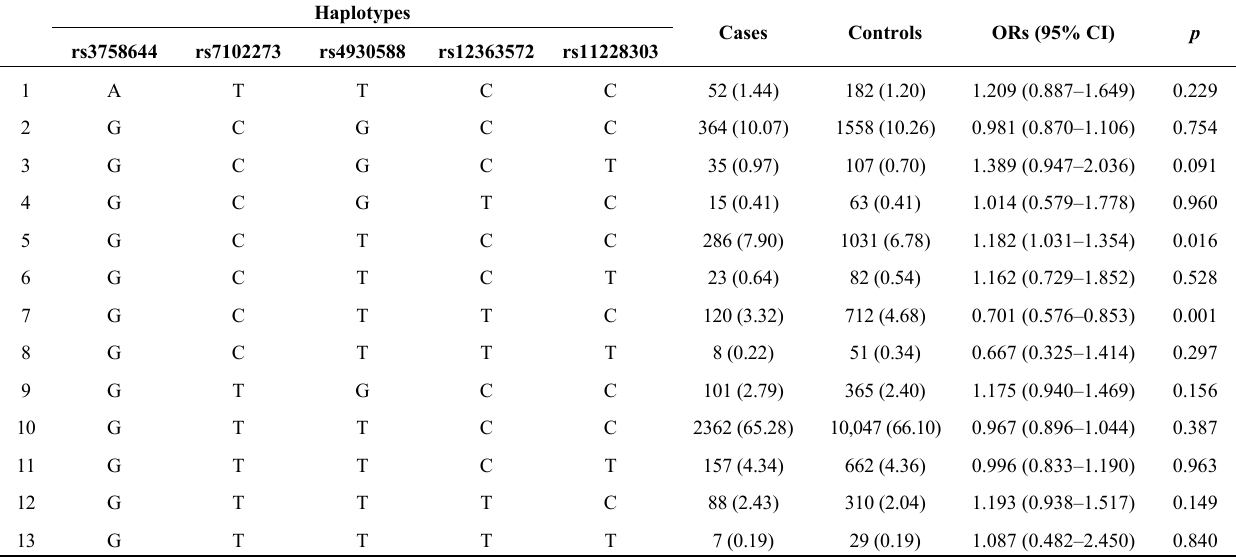
Table 4. Associations of haplotypes of SNPs in LRP5 gene and